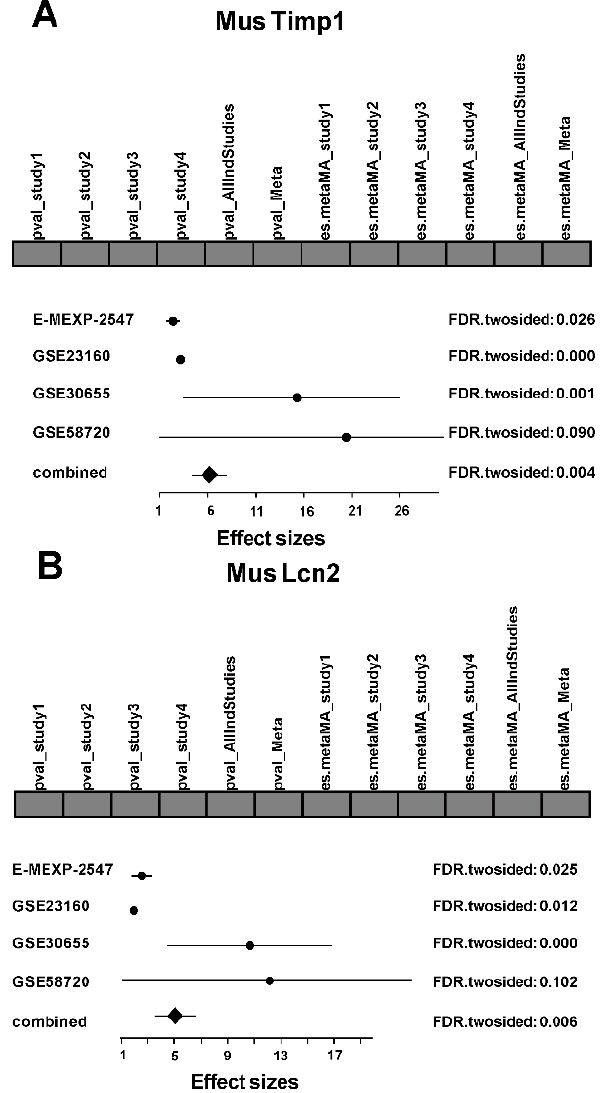
Figure 3. Cont. Figure 3.